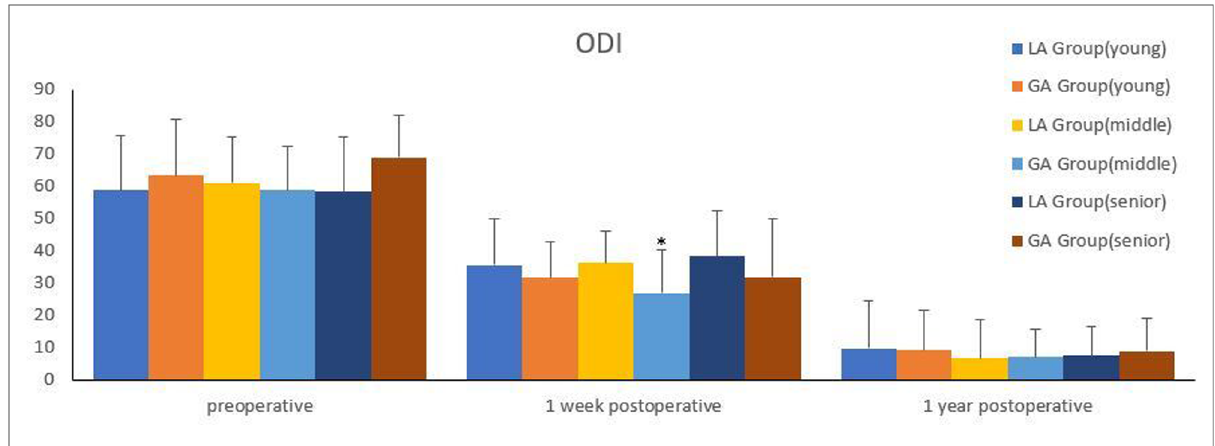
FIGURE 5 Comparison of ODI between the two groups in different age groups. *Compared with the LA group at one week postoperatively in the middle-aged group, P